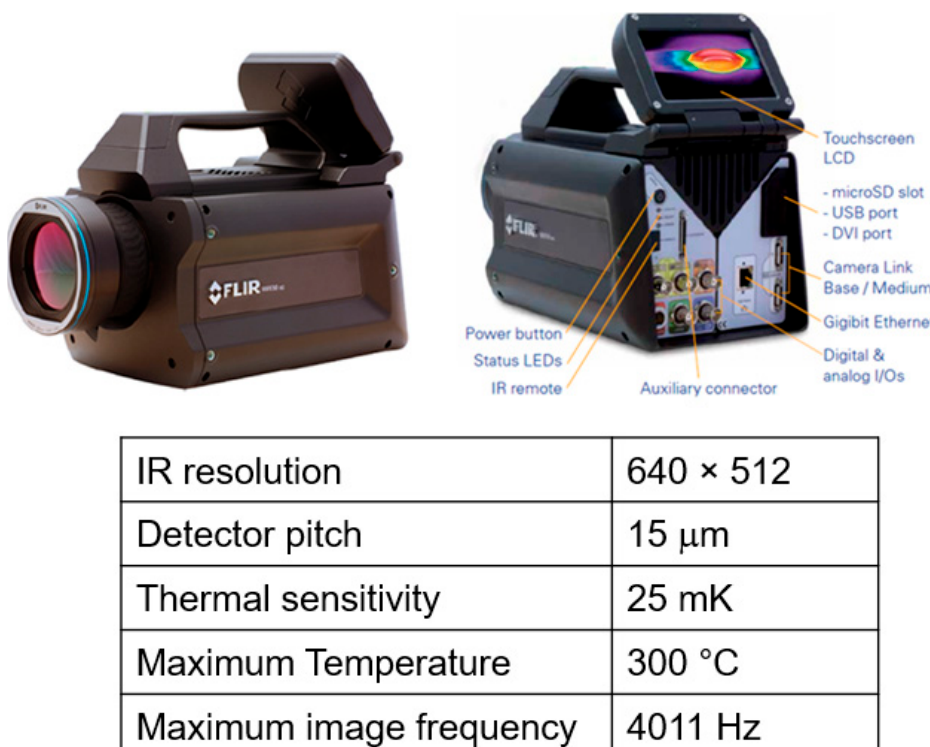
Figure 10. FLIR 6540sc infrared camera used to monitor temperature profile of the printed parts. The table summarizes the camera specifications [29].